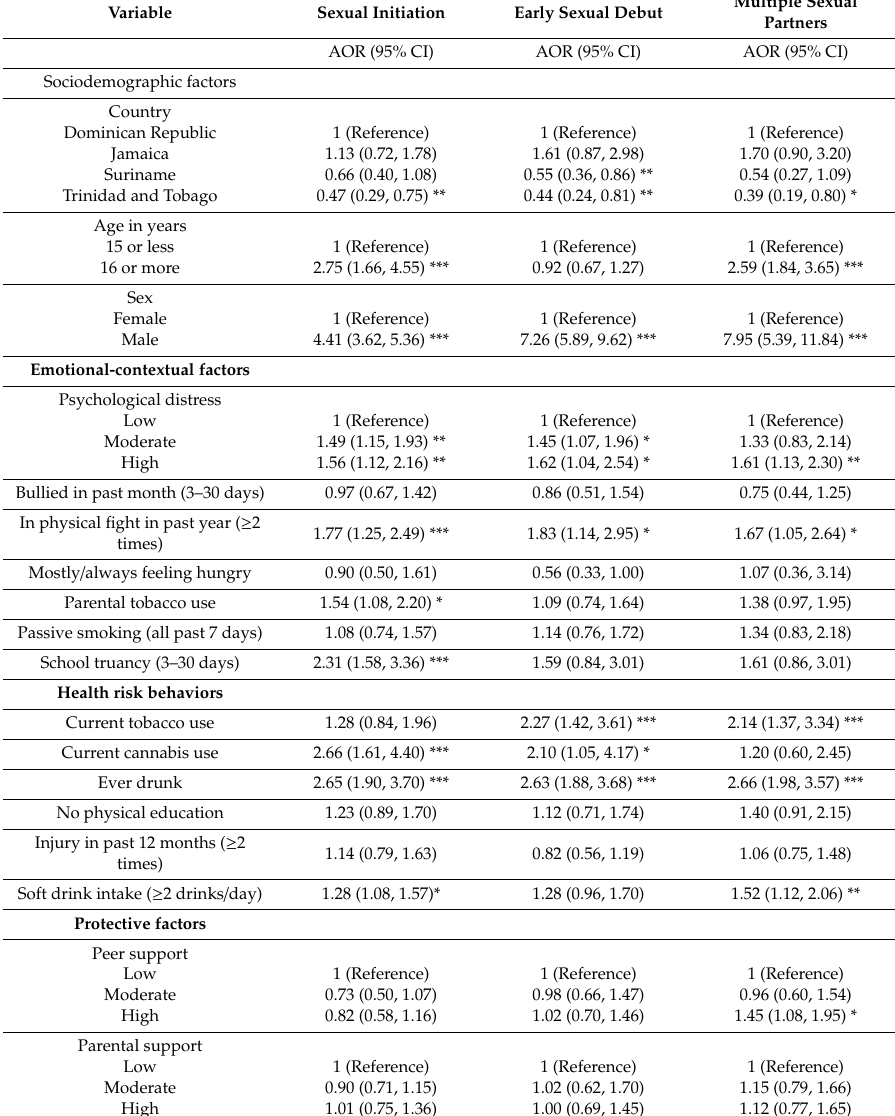
Table 4. Associations with sexual initiation, early sexual debut, and multiple sexual